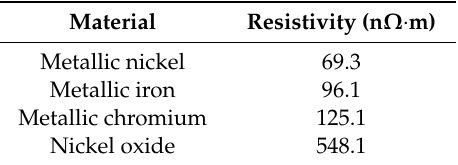
Table 2. Resistivity of the main constituents of the film at 20 °C [31,32].